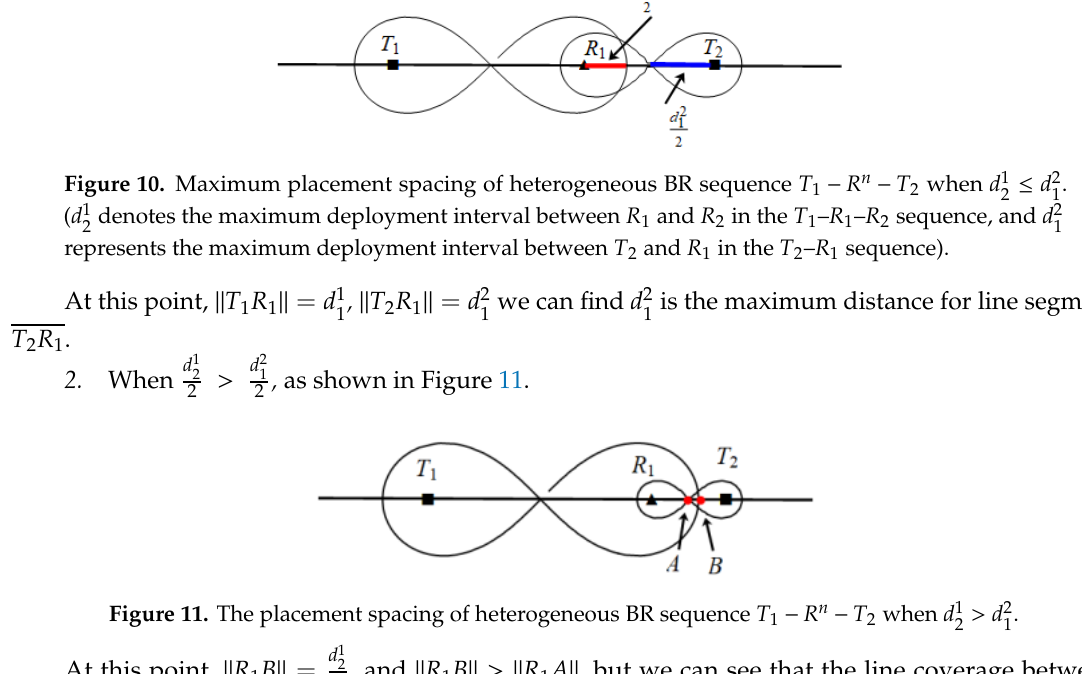
n T R T   d d  when 1 . > d 2 . 2 1 · l = l = l 2 , 1 1 max 1 · l = l = l 2 . At this point, the detectability 2 2 max 2 l 2 2 , then (cid:107) T 2 B (cid:107) = , (cid:107) T 2 R 1 (cid:107) = . As a result, (cid:107) T 1 R 1 (cid:107) = d 1 2 1 d 1 /2 2